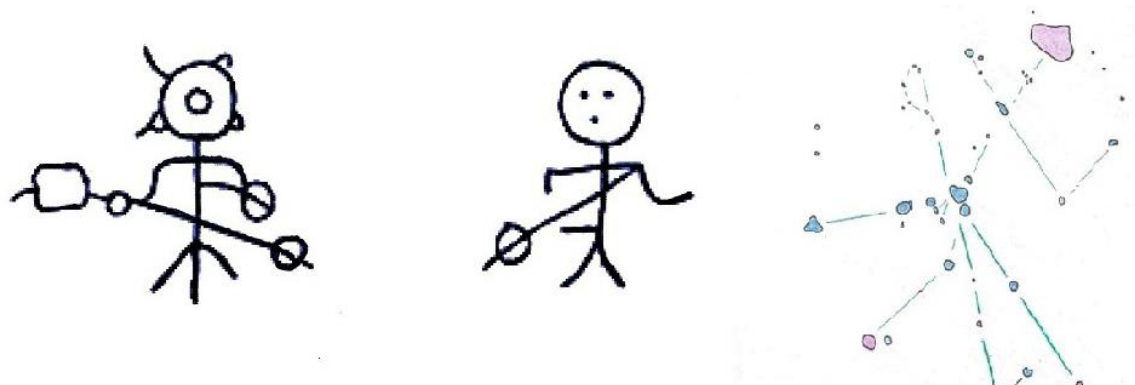
Figure 20. Petroglyphs of stickmen bearing atlatls with an erection at the Jeffers Petroglyph site in the same pose as the Starman petroform (at right) with a massive erection and bearing a loop-handled atlatl. The pecked image at left is approximately 0.8m long, the middle figure approximately